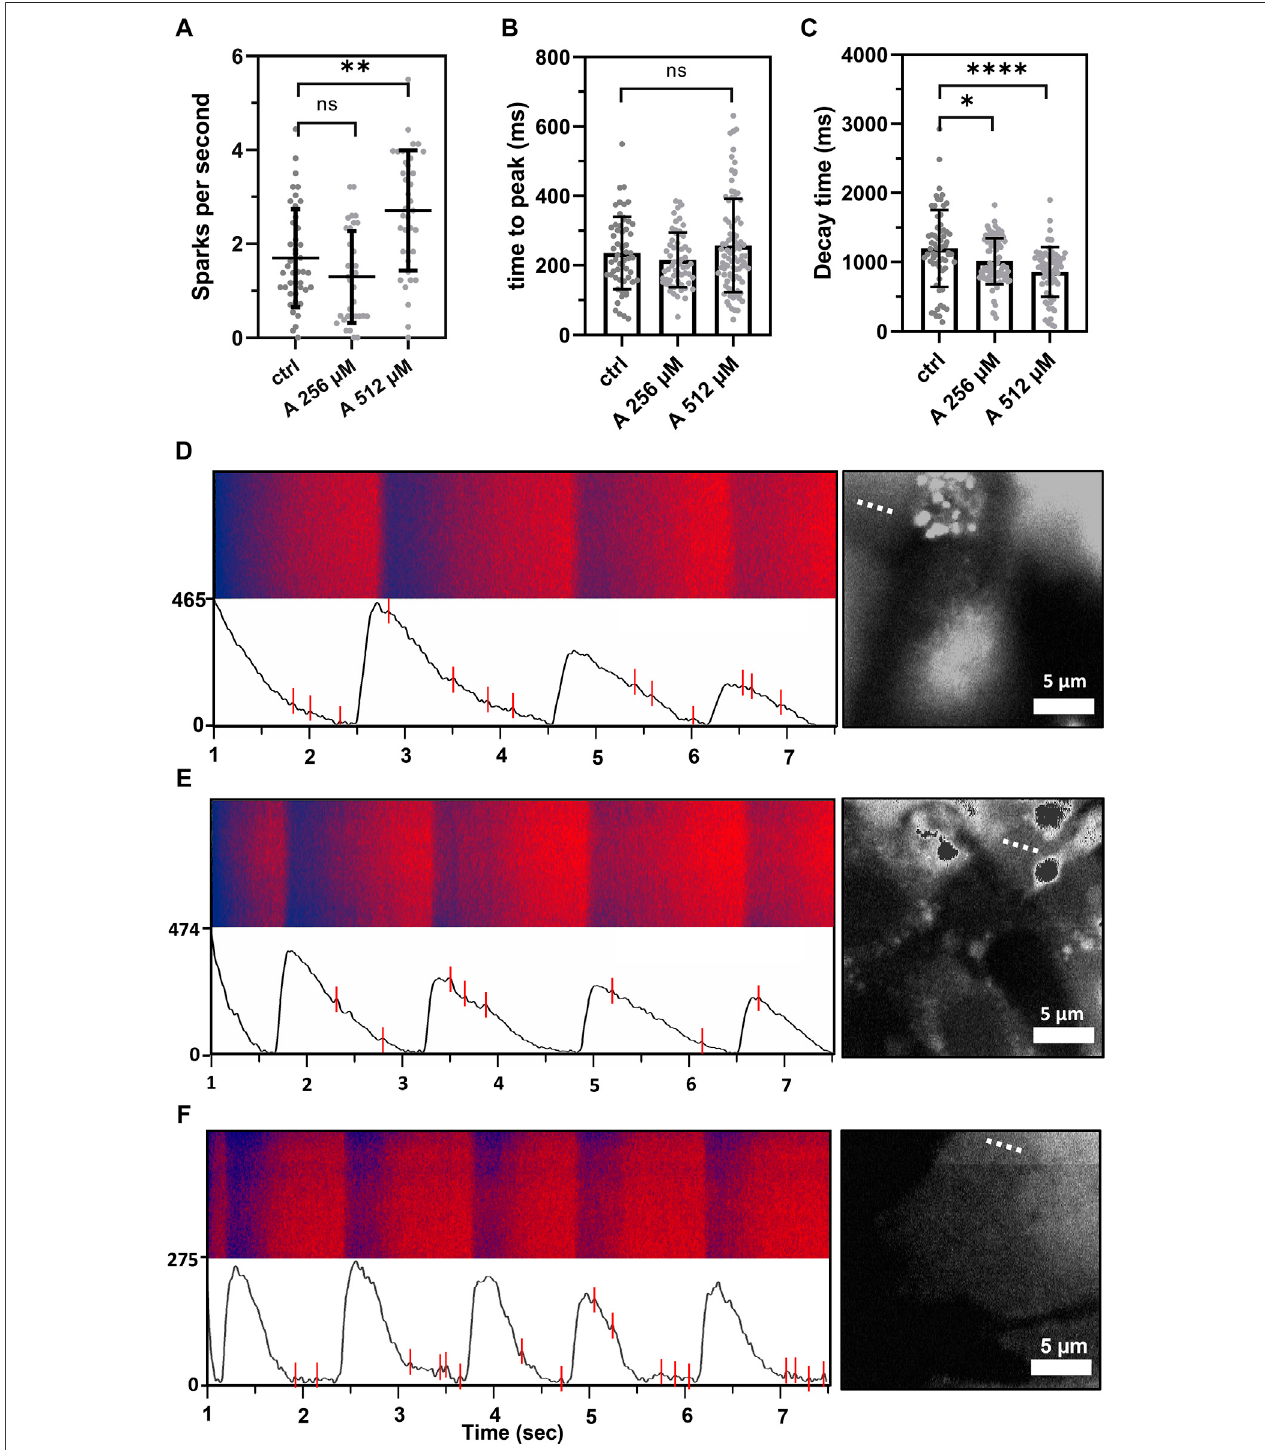
FIGURE 6 | Calcium sparks measured as extra events in the fl uorescence in-time signal, showing leakage of calcium from the sarcoplasmic reticulum. (A) Scatterplot (mean ± standard deviation) showing calcium leakage events in a one-second period in control cells compared to the treatment by 256 and 512 μ M aminophylline (A; n (cid:2) 43 for ctlr, n (cid:2) 33 for 256 µM and n (cid:2) 37 for 512 µM). The frequency of calcium leakage events of cells treated with 512 µM aminophylline was signi fi cantlyhigherthanthatofthecontrol(A512vs.ctlr p < 0.01,ordinaryone-wayANOVA). (B,C) Scatterplots(mean ± standarddeviation)showingtimestopeak and decay times of the control compared to the treatments. Aminophylline caused no signi fi cant change to time to peak compared to the control; however, decay time